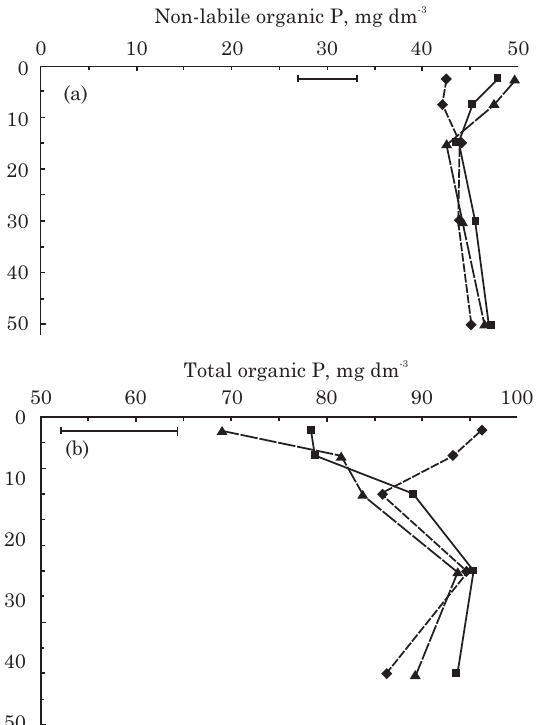
Figure 5. Non-labile and total soil organic P in the soil profile as affected by surface- broadcast P fertilizers. (a) Non-labile organic P; (b) Total organic P. Dotted line – No P; dashed line - natural reactive Arad phosphate; solid line – triple superphosphate. Horizontal bars show LSD (p<0.05) and compare treatments within each soil